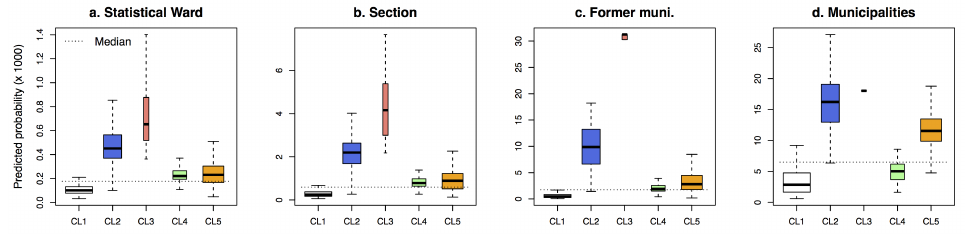
Figure A.3: Variations of predicted probability per cluster for the Polycentric case study (box-plots width is function of the number of observations)